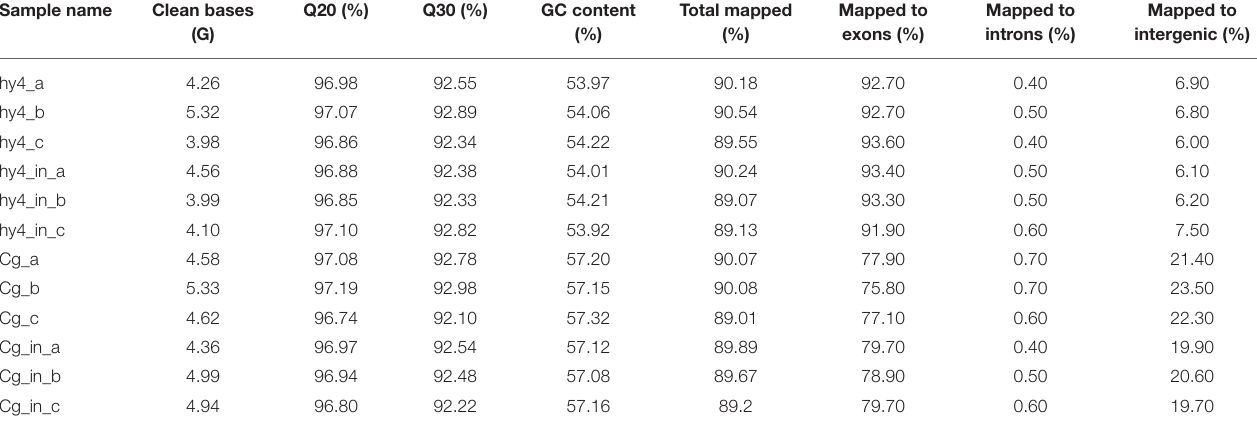
TABLE 2 | RNA sequencing information for the two HupA-producing endophytes P. polonicum hy4 and C. gloeosporioides Cg01 in the control group and induced